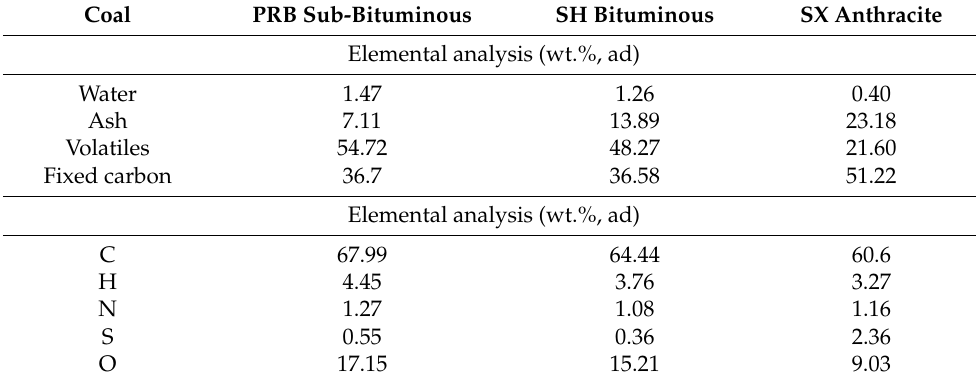
Table 2. Experimental conditions and gas compositions of the flue gas. Coal PRB